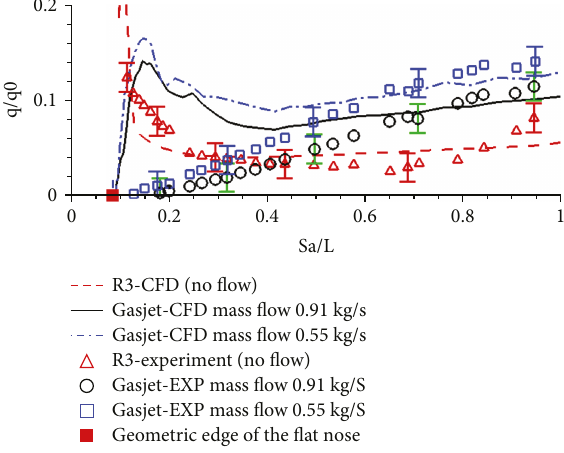
Figure 19: Heat transfer results of the Gasjet model against the baseline model and experiment, Re = 4 3 × 10 6 , α = 0 0 ° , M = 6 8